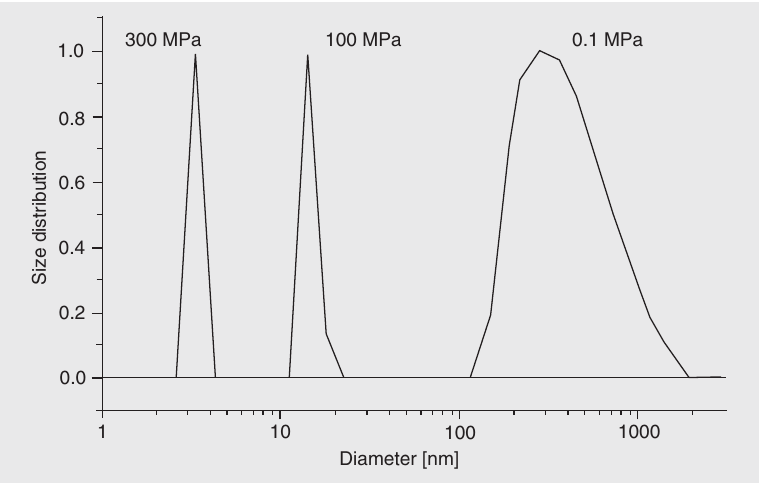
Figure 1. In situ size distribution of casein particles at three pressures derived from the intensity correlation function, z-distribution at 0.1 MPa and number distribution at 100 and 300 MPa (see text).